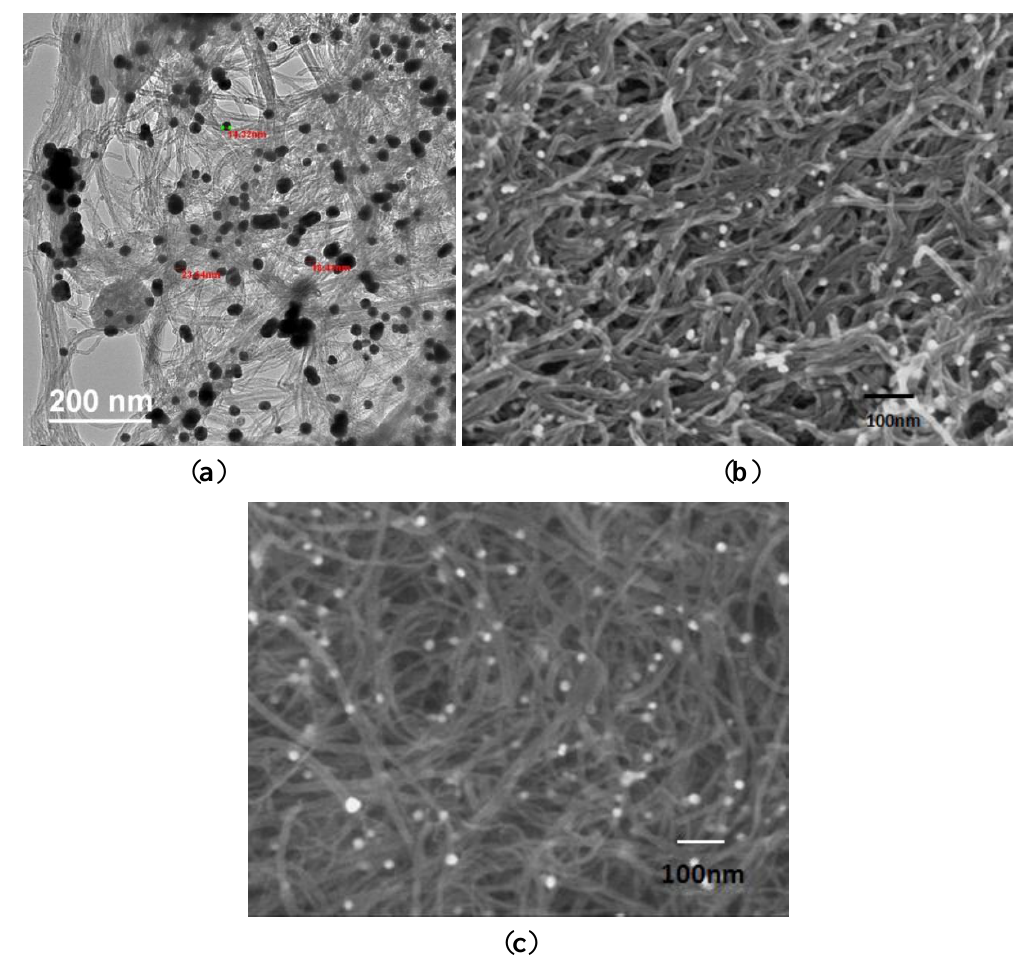
Figure 3. ( a ) Transmission electron microscopy image for buckypaper (BP) 1, ( b ) Scanning electron microscopy image for BP 2 and ( c ) scanning electron microscopy for BP